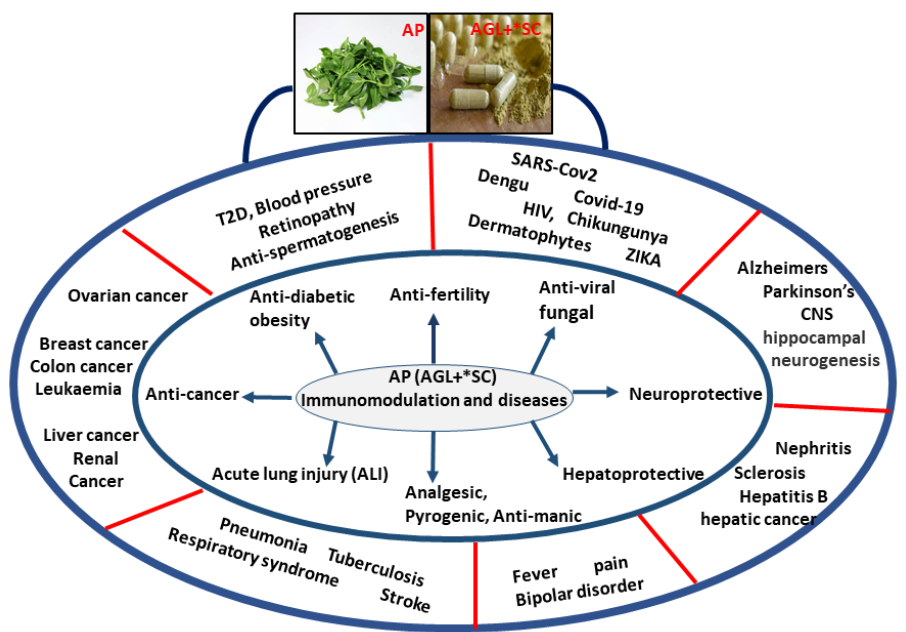
Figure 1. Possible role of Andrographis paniculate (AP) in medicine and human diseases. The disease prevention using andrographolide (AGL) is the combined effects of its anti-inflammatory, anti-oxi- dative, anti-pyrogenic, and immunomodulatory properties. *SC = synthetic compound.